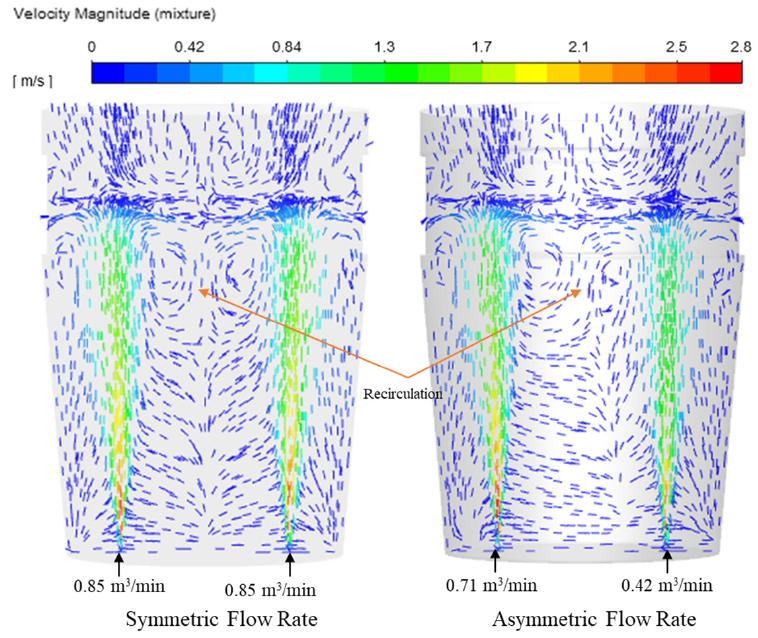
Figure 10. Vector contour of flow field.